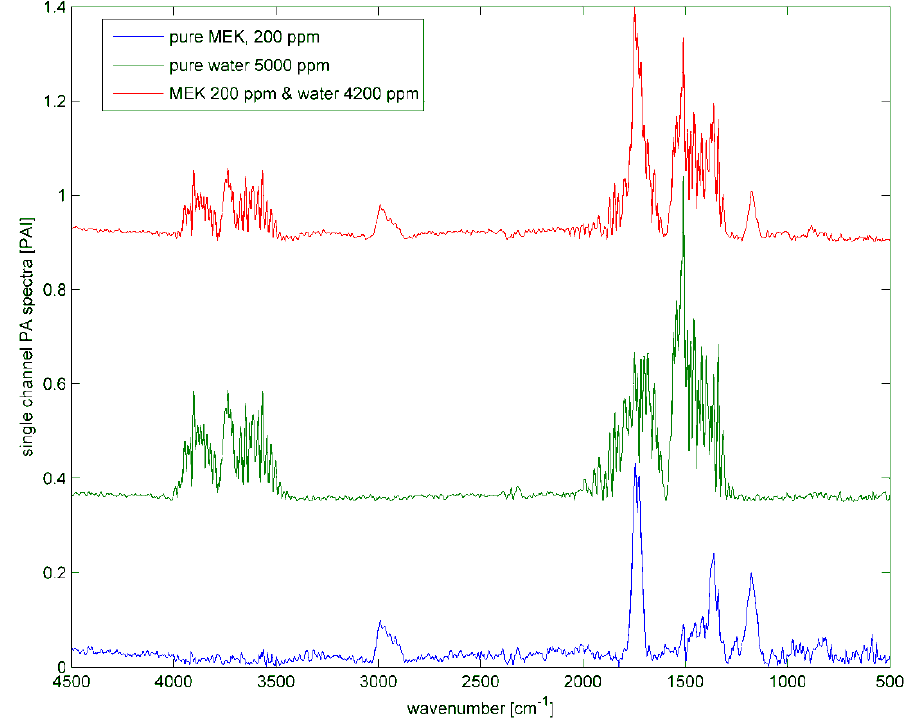
Figure 8. Demonstration of water overlapping with the analyte: If the pure MEK sample (blue) contains water (green), the measured spectra will be the sum of both (red).